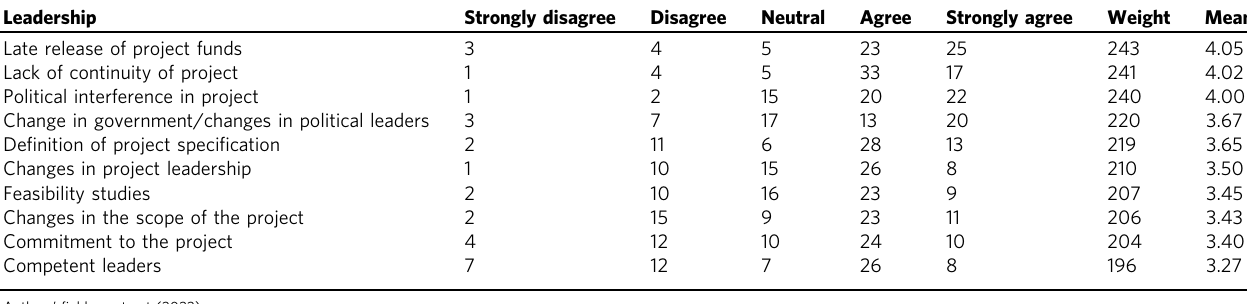
Table 3 Causes of project failure from leadership ( N = 60). Leadership